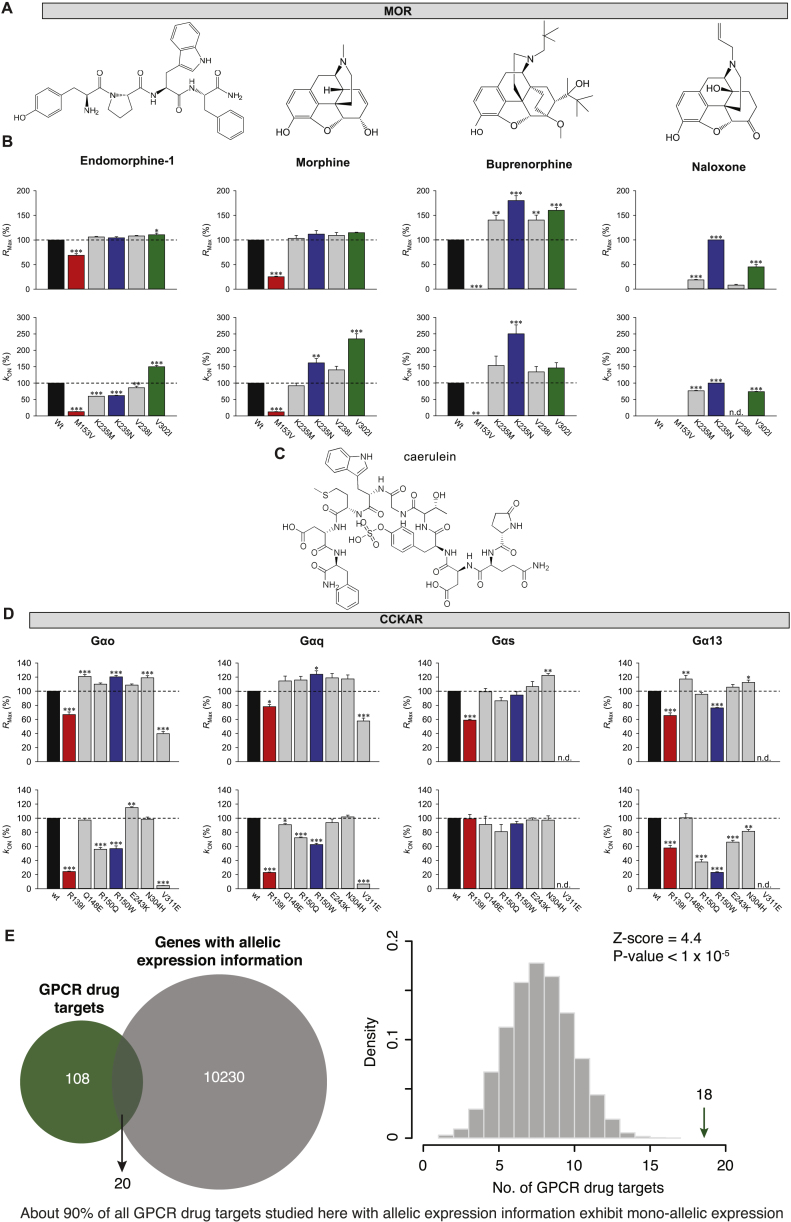
Effects of Mutations on RMax and kON for μ-Opioid Receptor and CCKAR and Allele-Specific Expression of GPCR Drug Targets, Related to Figure 5(A) Chemical structures of opioid receptor ligands.(B) The bar graphs quantitate the relative RMax and kON of μ-opioid receptor mutants to μ-opioid receptor wild-type.(C) Chemical structure of Cholecystokinin receptor ligand caerulein.(D) The bar graphs quantitate the relative RMax and kON of CCKAR mutants to CCKAR wild-type. For both panels, results are expressed as the mean ± SEM. One-way ANOVA with Dunnett post hoc multiple comparison test relative to “wild type receptor,” ∗p < 0.05, ∗∗p < 0.01, ∗∗∗p < 0.001, n = 3 independent experiments.(E) Enrichment of GPCR drug targets among genes with mono-allelic expression. The Venn diagram shows the overlap between GPCR drug targets and the genes with allelic expression data. Enrichment was tested with permutation tests by performing 100,000 iterations. The random expectation (gray histogram) and the actual observation (green arrow) of GPCRs with mono-allelic expression are shown on the right.